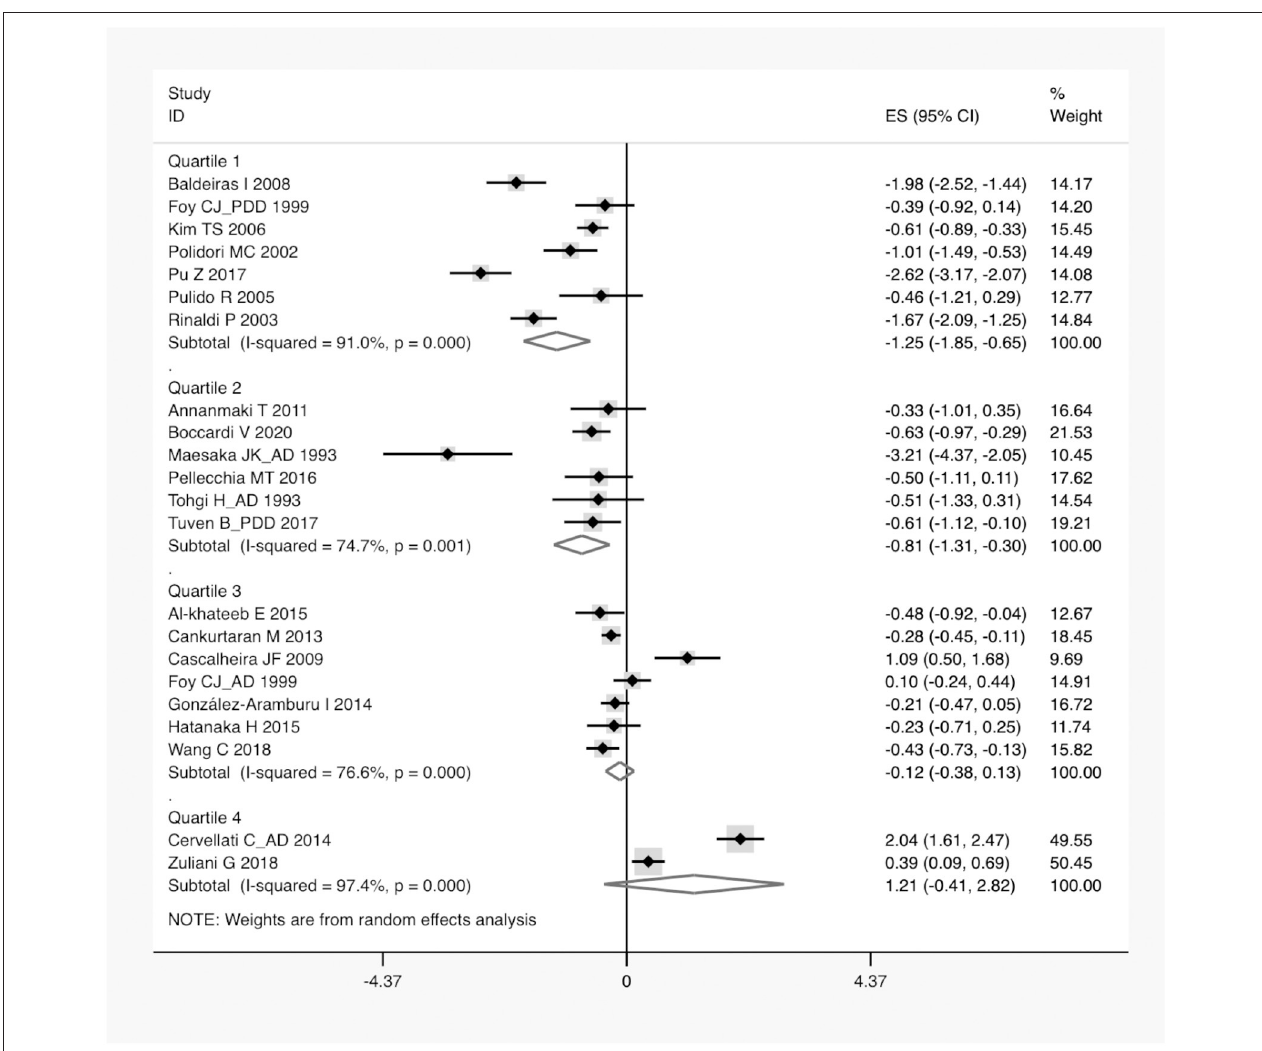
FIGURE 5 | A forest plot of the subgroup analysis on the concentration of serum UA in neurodegenerative dementia compared with non-dementia. ES, effect size; CI, confidence interval; UA, uric acid.